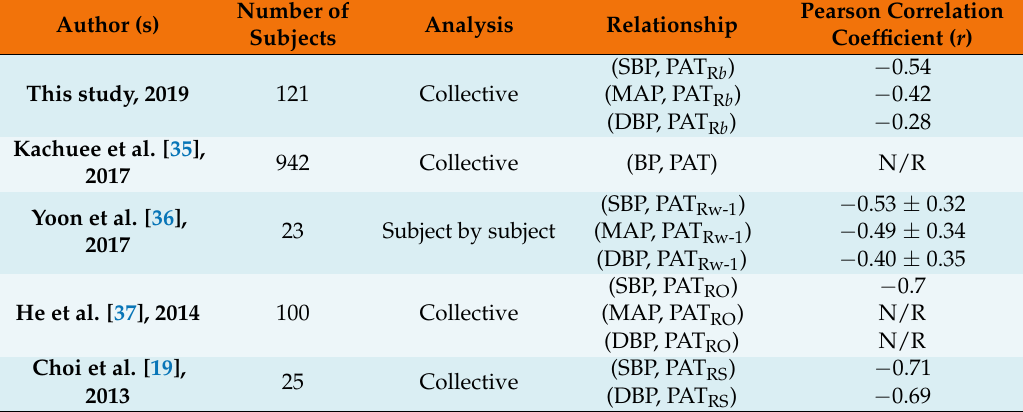
Table 6. Studies on the Pearson’s correlation relationship between blood pressure and pulse arrival time features, using the MIMIC database. Note, SBP refers to systolic blood pressure, DBP refers to diastolic blood pressure, MAP refers to mean arterial pressure, PAT refers to pulse arrival time, r refers to Pearson’s correlation coefficient, and N/R refers to not